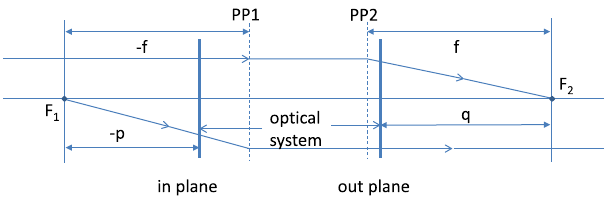
FIG. 1. Focusing points and geometrical parameters in a conventional optical